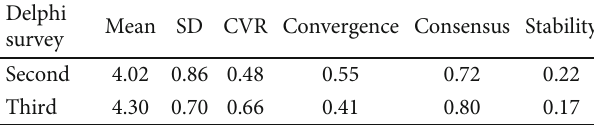
Table 1: Comparison of the second and third Delphi survey